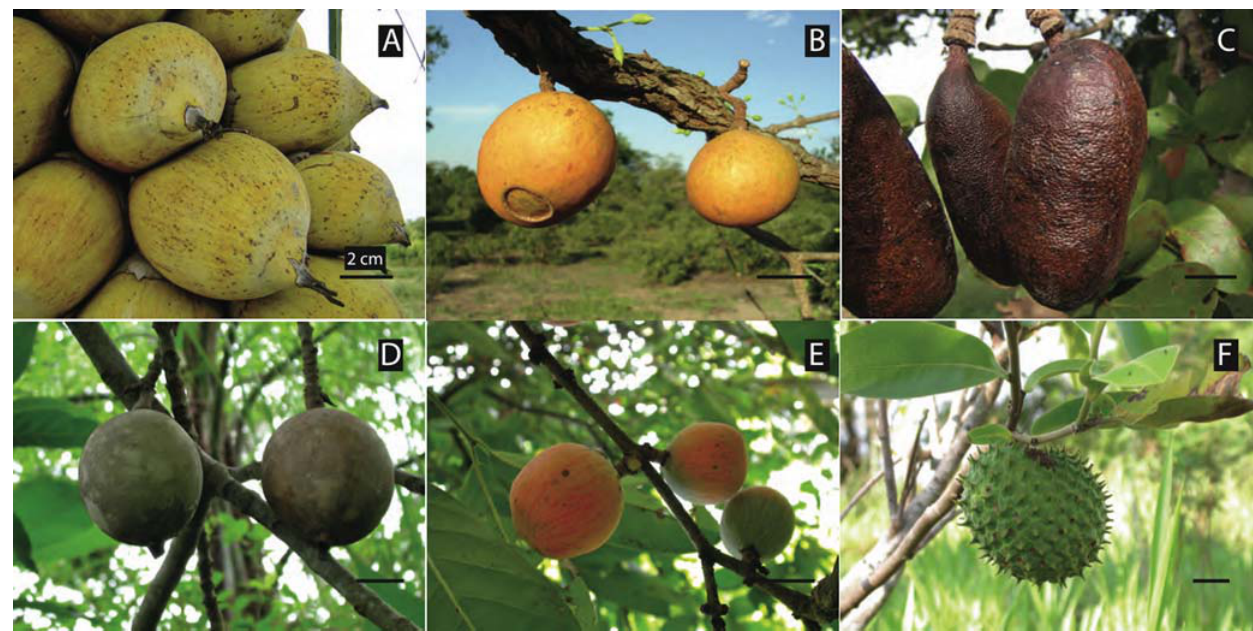
Figure 2. Fleshy fruited megafaunal-dependent species illustrating size, shape, and color variation. a, Attalea speciosa , Arecaceae; b, Mouriri elliptica , Melastomataceae; c, Hymenaea stigonocarpa , Fabaceae; d, Genipa americana , Rubiaceae; e, Salacia elliptica , Celastraceae; f, Annona dioica , Annonaceae. Black reference line is 2 cm length. Photos from Fazenda Rio Negro, Pantanal, Brazil; by PJ, MG, and Camila I. Donatti.